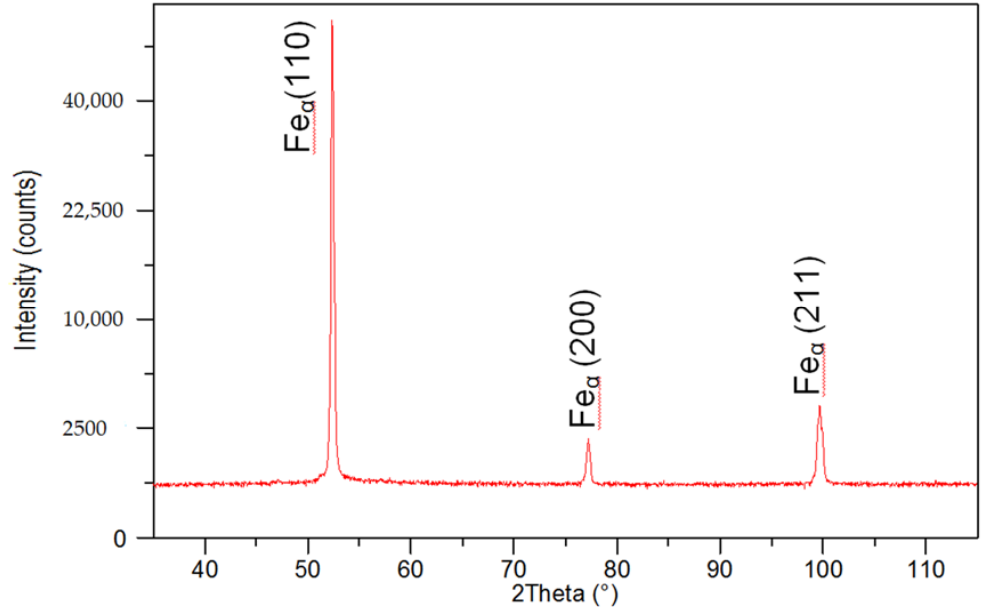
Figure 13. XRD pattern of the weld of the laser-welded joint made of steel S700MC.